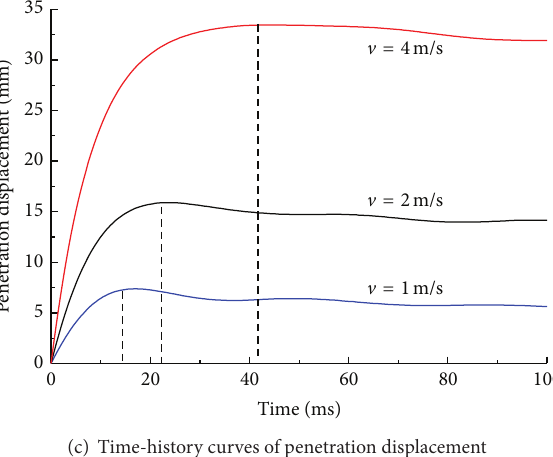
and 𝑚 = 6 kg. The figure indicates that the simulant lunar soil beneath the footpad moves downward and extrudes towards the periphery, resulting in a basin-shaped